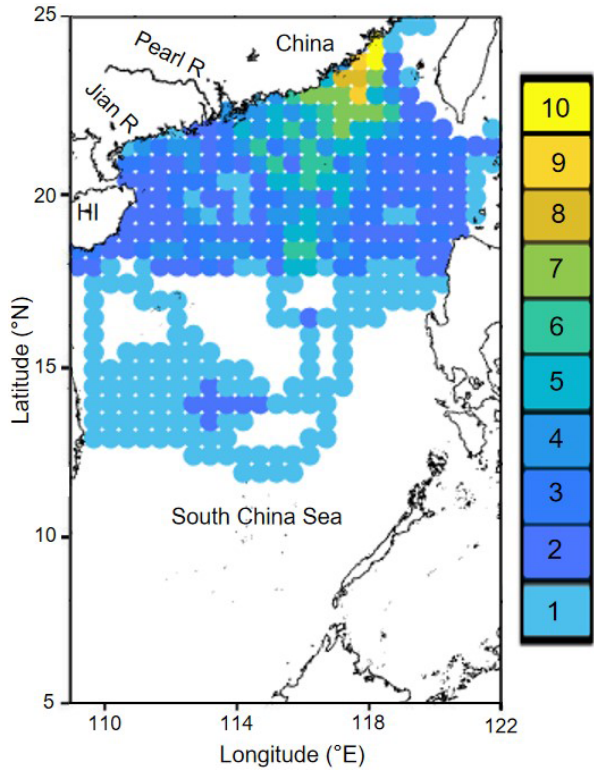
Figure 2. The number of summers with underway sea surface p CO 2 observations in the SCS in the years 2000–2017. HI repre- sents Hainan Island; Jian. R. is the Jianjiang River; and Pearl R. represents the Pearl